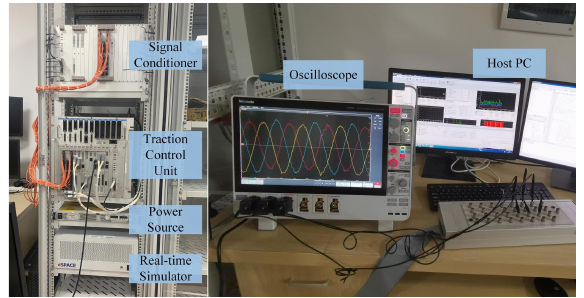
Figure 4. The HIL test